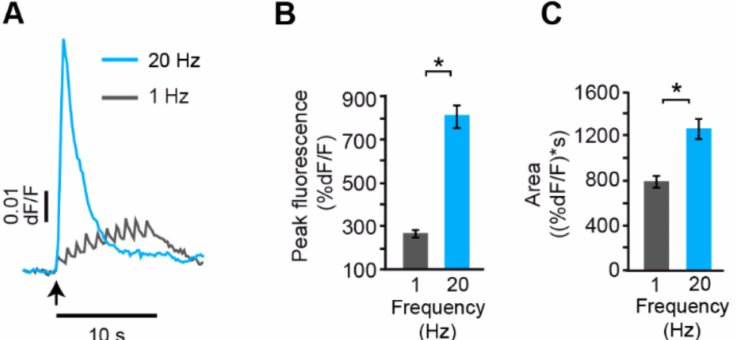
Figure 5. Frequency dependence of calcium signals. ( A ) Calcium transients at the vicinity of the plasma membrane. ( B ) Peak amplitude of the transients. ( C ) Integral of the calcium tran- sients. The supralinear summation of calcium upon 20 Hz stimulation seen from the difference between the amplitude and the integral of the transients suggest an additional calcium component. The * indicates p < 0.05 significant differences. Obtained with permission from [40].